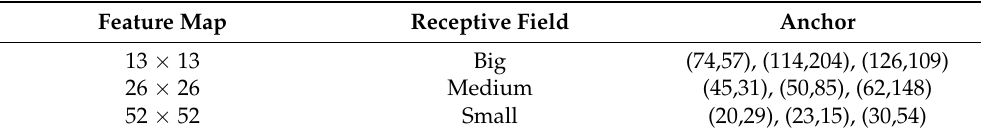
Table 2. Nine sets of prior boxes obtained by K-means++. Feature Map